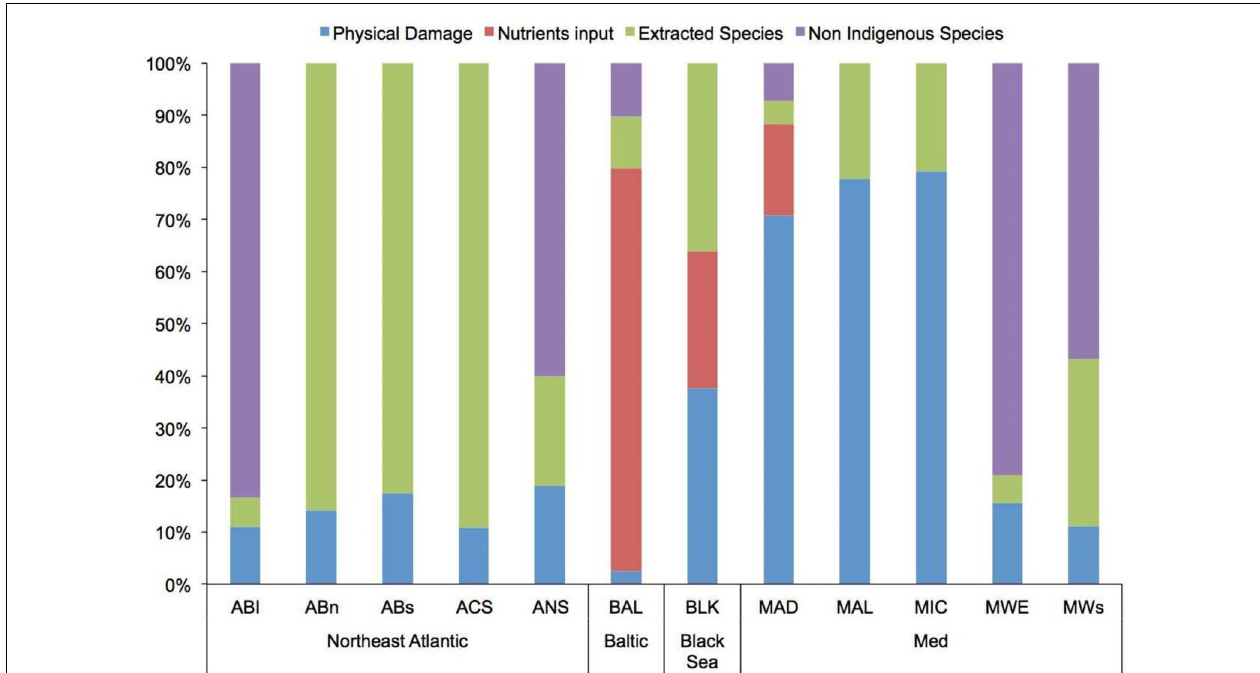
FIGURE 5 | Top priority pressures reported by the EU Member States in the initial assessment of their marine environment at the first cycle of the MSFD. Results were aggregated to regional or sub-regional level. Northeast Atlantic includes the subregions of Celtic Sea (ACS), North Sea (ANS), North and South Bay of Biscay and Iberian Coast (ABn, ABs, and ABI). The Mediterranean Sea includes the subregions of Adriatic (MAD), Aegean and Levantine Sea (MAL), Ionian and Central Mediterranean (MIC), and Western Mediterranean (MWE and MWs).